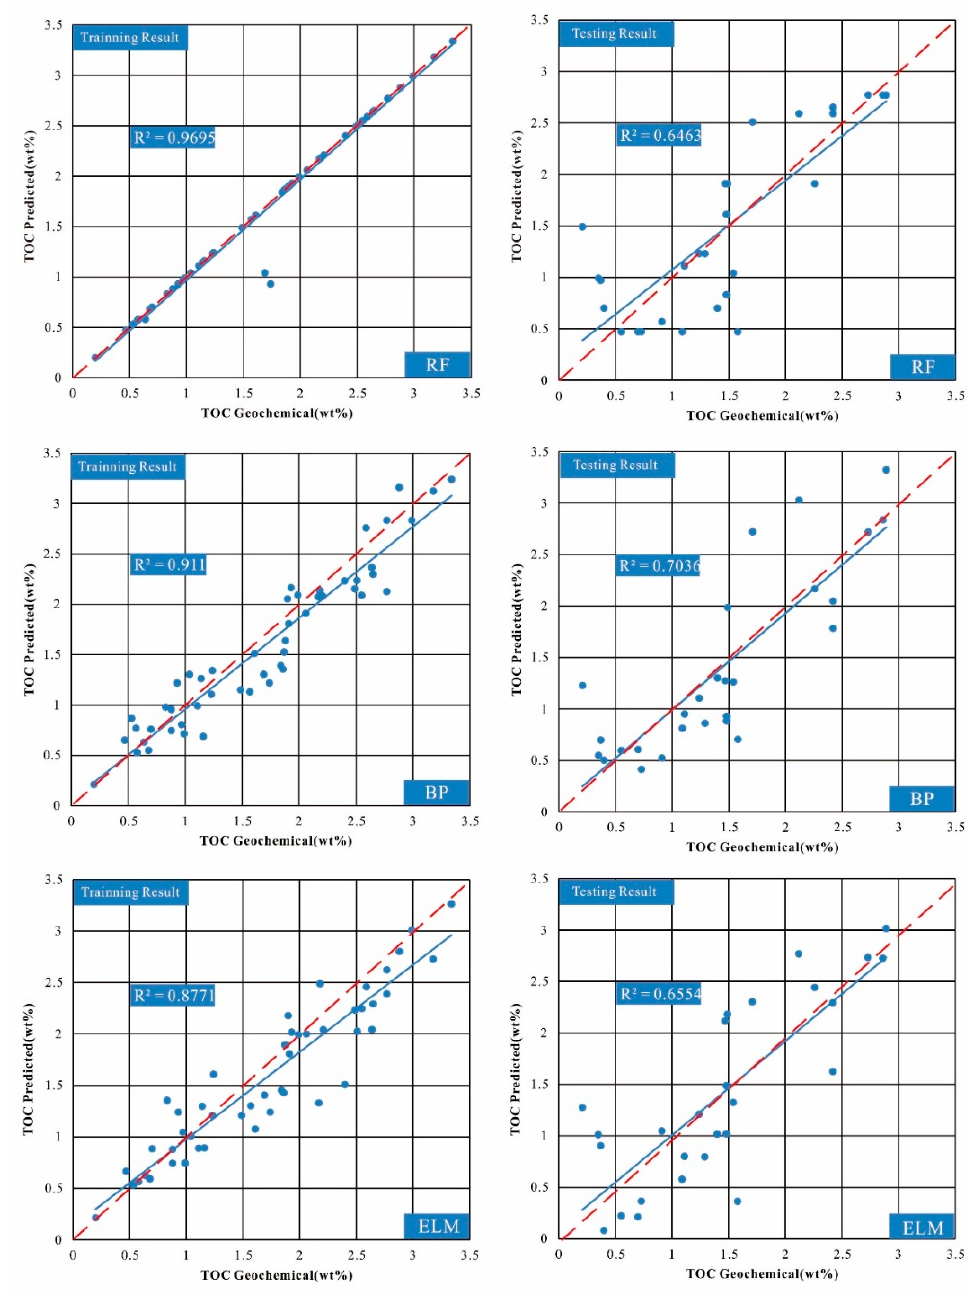
Figure 8. Cross plots between TOC values from ML models using HXC and TOC values from core data.